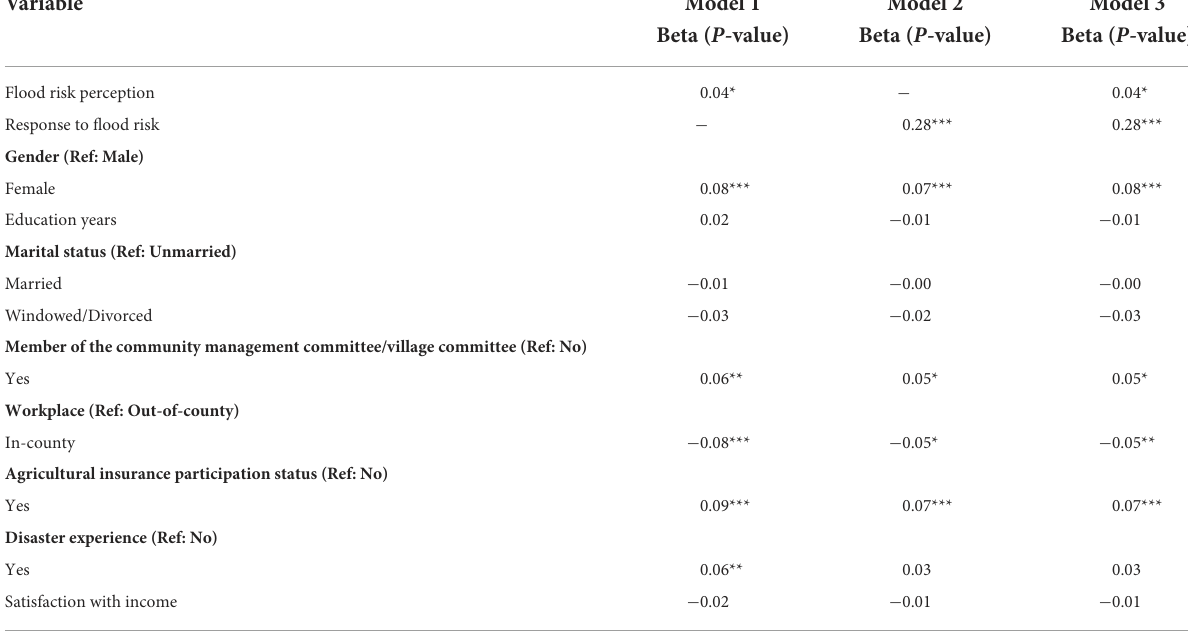
TABLE 3 The relationships among flood risk perception, response behaviors, and COVID-19 preventive behaviors ( N = 2,283).